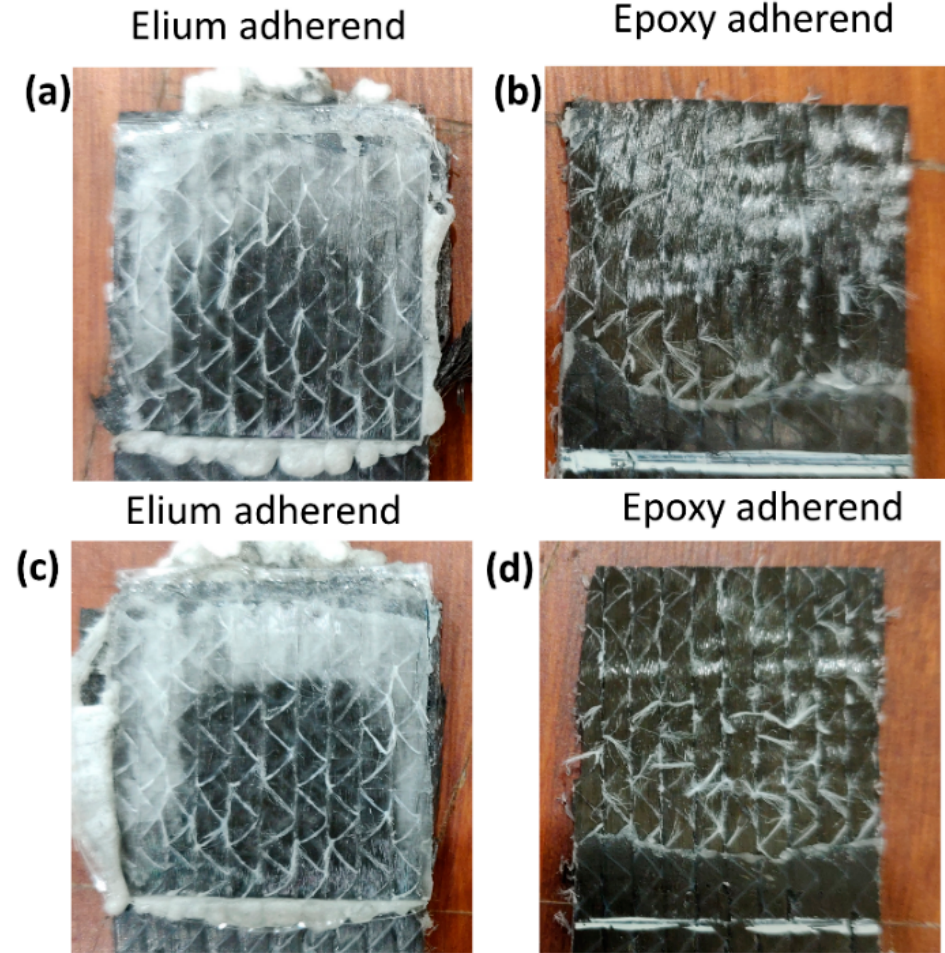
Figure 14. Fracture surfaces of EL-EP(Elium ® - Epoxy)_0.5 ( a , b ) maximum Lap shear strength and ( c , d ) minimum Lap shear strength.